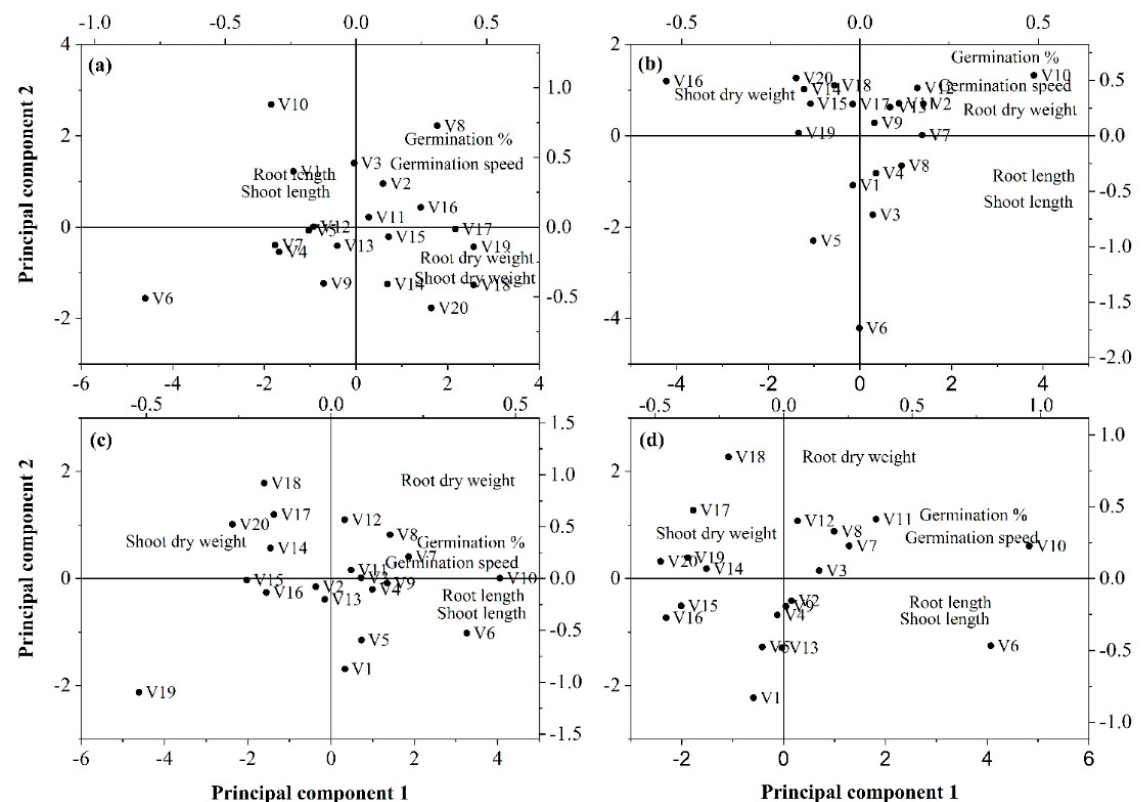
Figure 2. Screening of twenty wheat varieties grown at different drought levels. Germination percentage and seedling growth parameters were measured and plotted in Principal Component Analyses (PCA). ( a ) 0% PEG-6000; ( b ) 2% PEG-6000; ( c ) 4% PEG-6000; and ( d ) 6% PEG-6000.